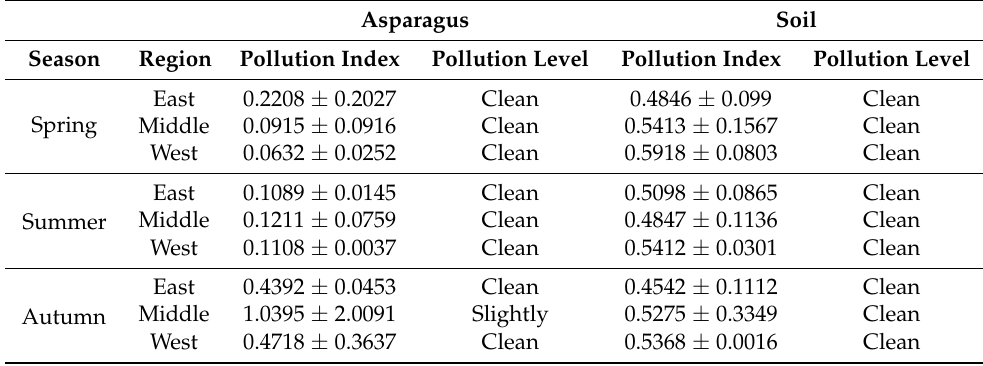
Table 5. Nemerow pollution index of asparagus and